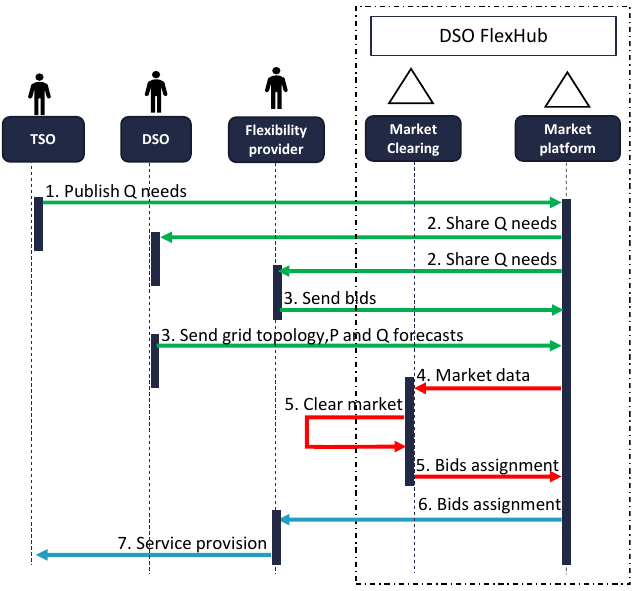
Figure 1. Market agents and actions sequence.